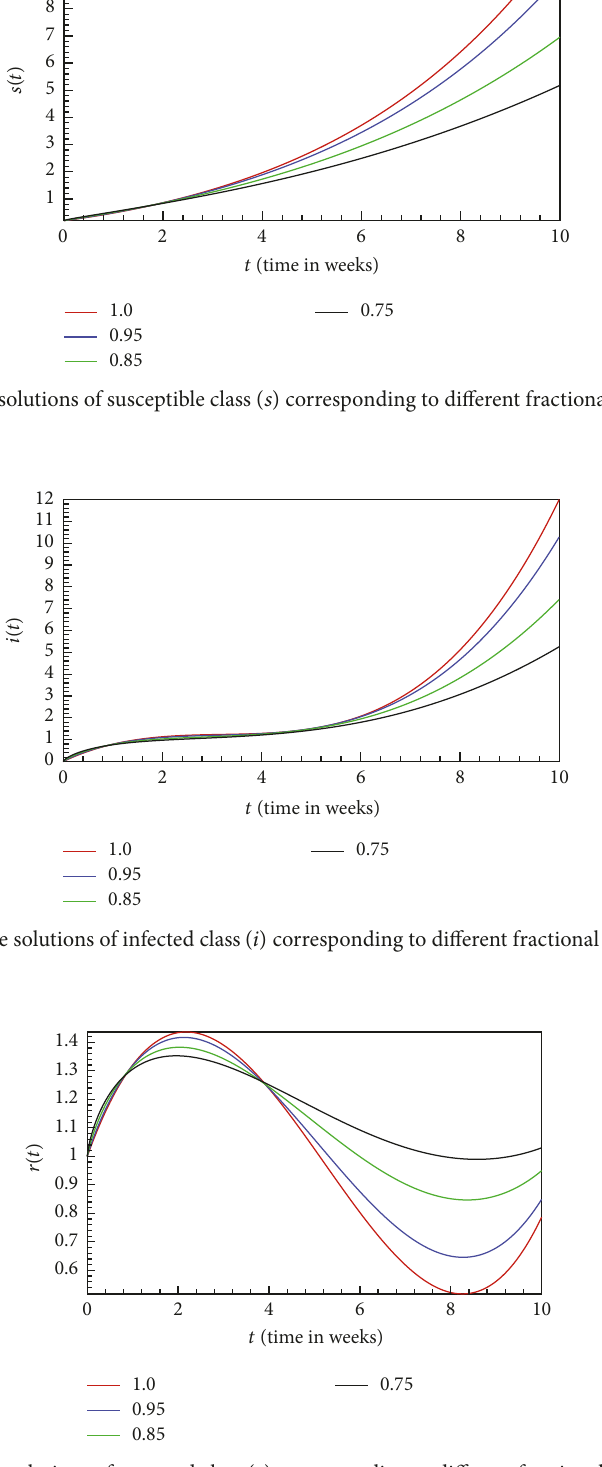
Figure 3: Plot of approximate solutions of removed class (𝑟) corresponding to different fractional values of 𝛼 𝑘 for 𝑘 = 1, 2, 3